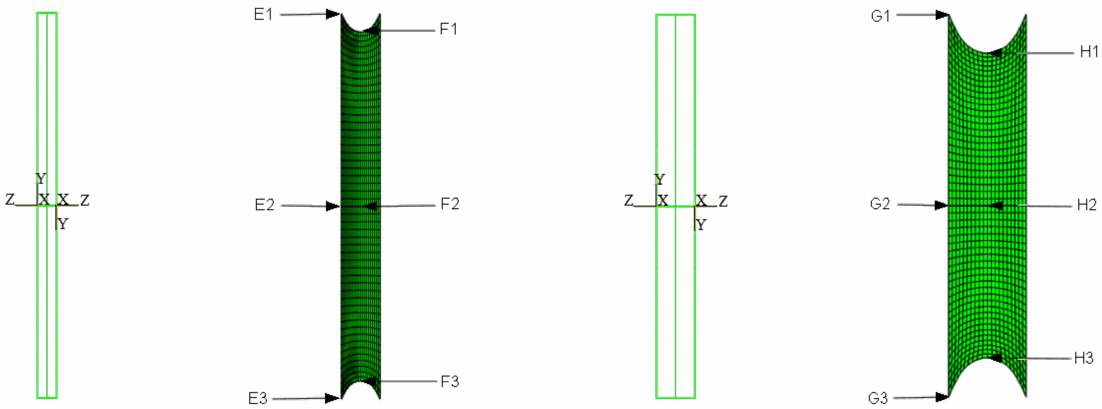
Figure 16. Material in dilatation gap numerical model. Plane strain problem. Expansion joint geometry and local coordinate systems on connection planes, first and third graphics. Selected nodes on connection and central plane, second and fourth graphics. The width of the gap is equal to 1.0 cm, left, and 2.0 cm, right.